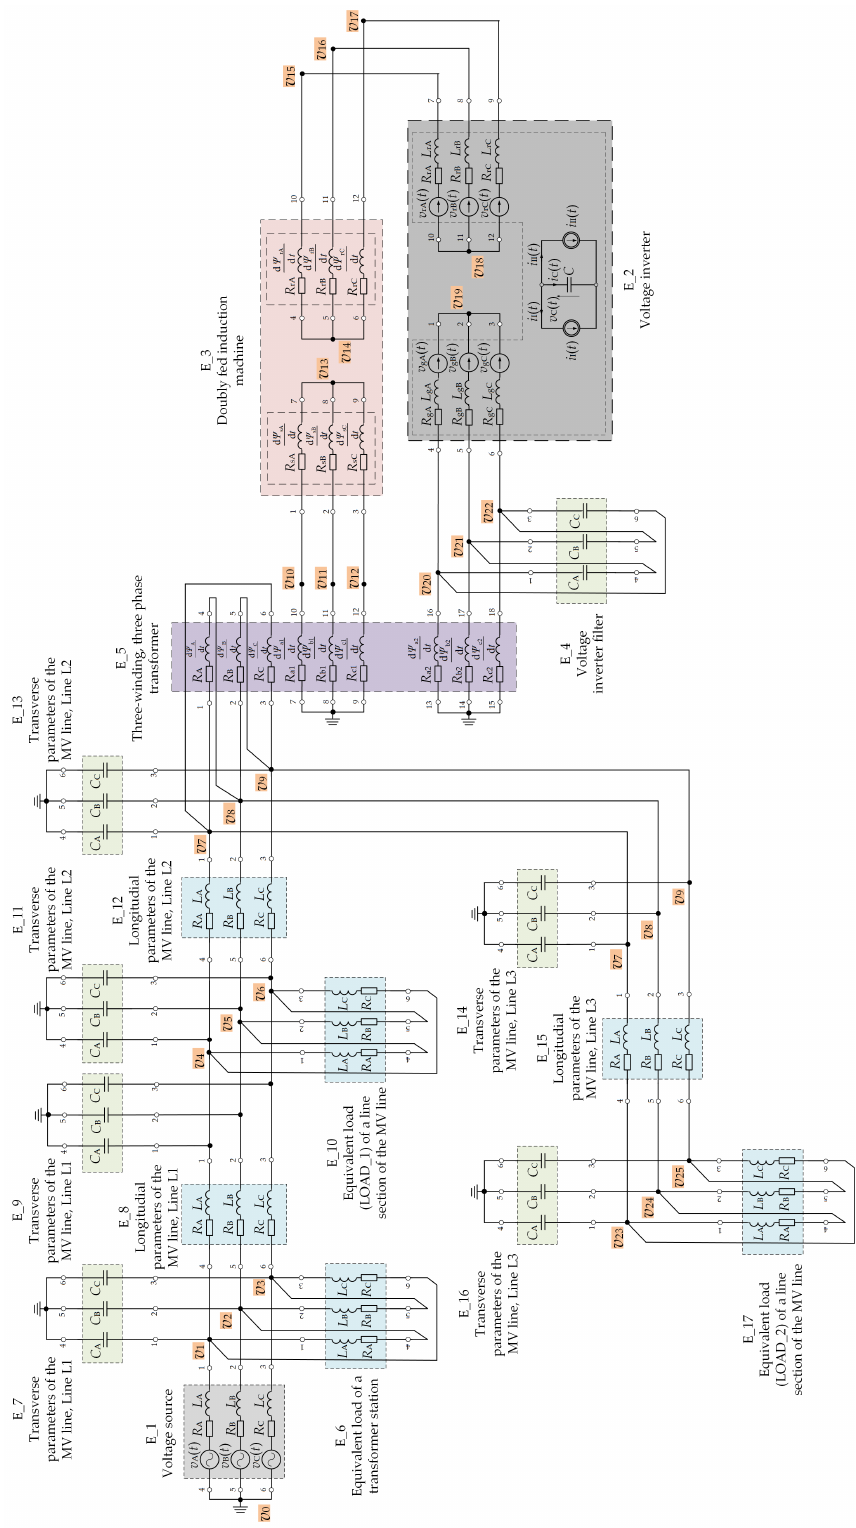
Figure 13. Equivalent diagram of the analyzed power system with the use of